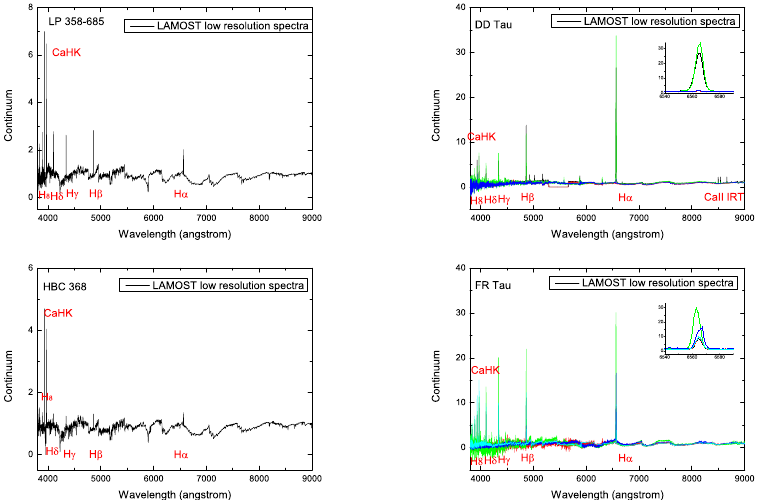
Figure 1. Examples of the low resolution LAMOST spectra of several radio stars with single ( left ) and repeated ( right ) observations. We marked several important spectral lines with obvious emissions in the Ca II H&K, H δ , H γ , H β , H α , and Ca II IRT lines. There are obvious variations in the H α line in the small